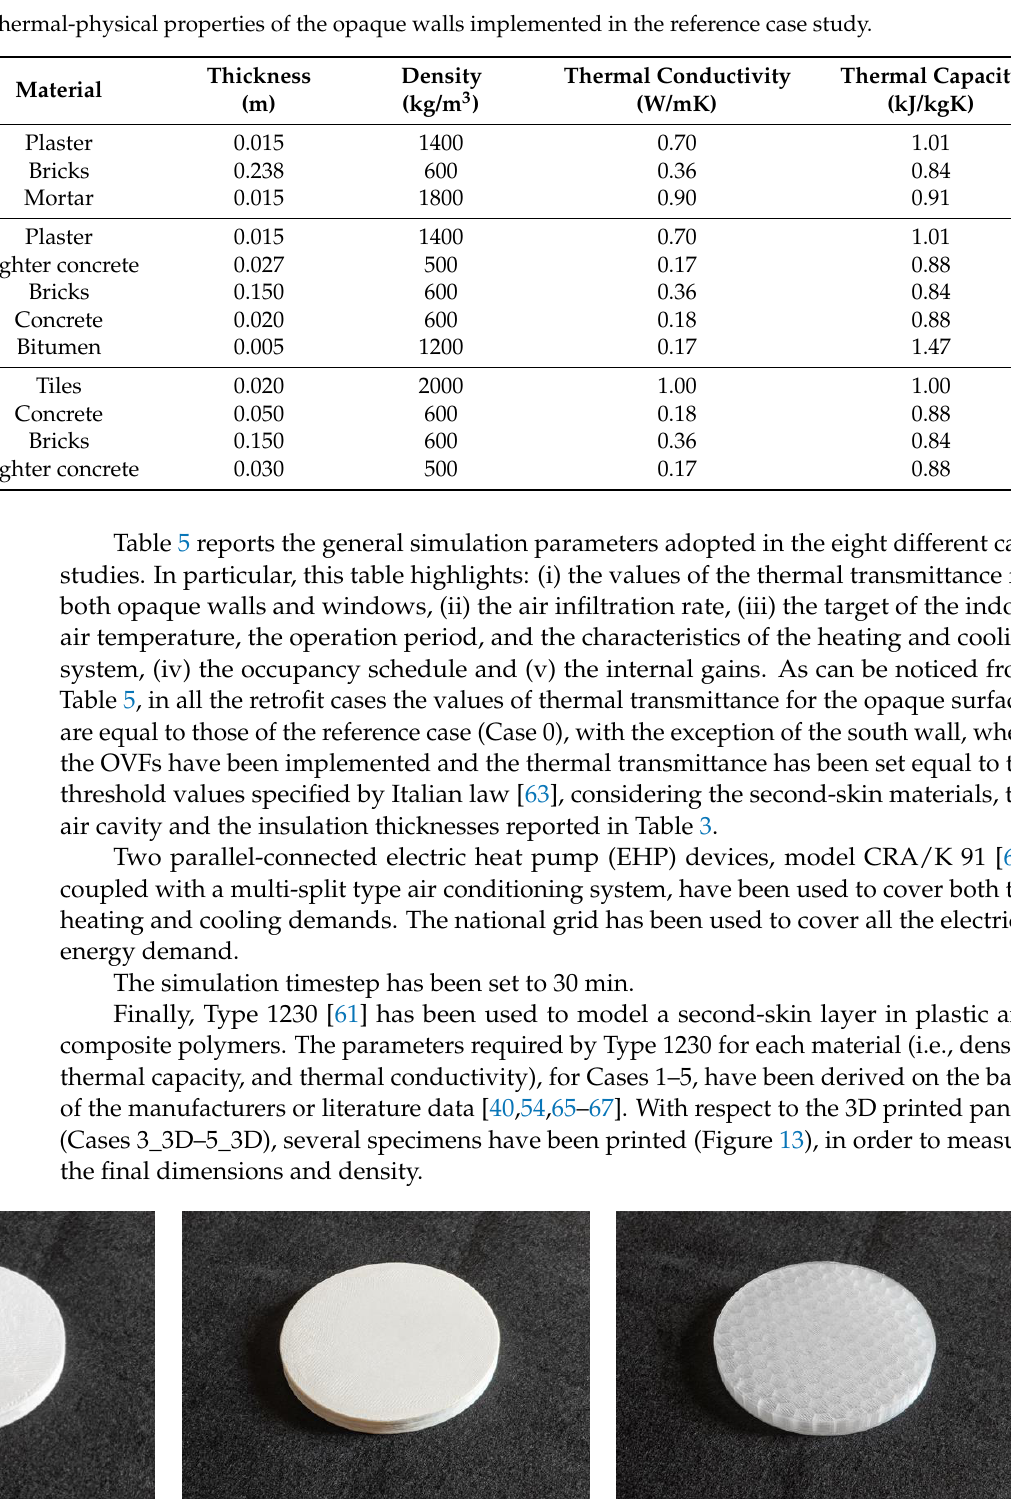
Table 4. Thermal-physical properties of the opaque walls implemented in the reference case study.